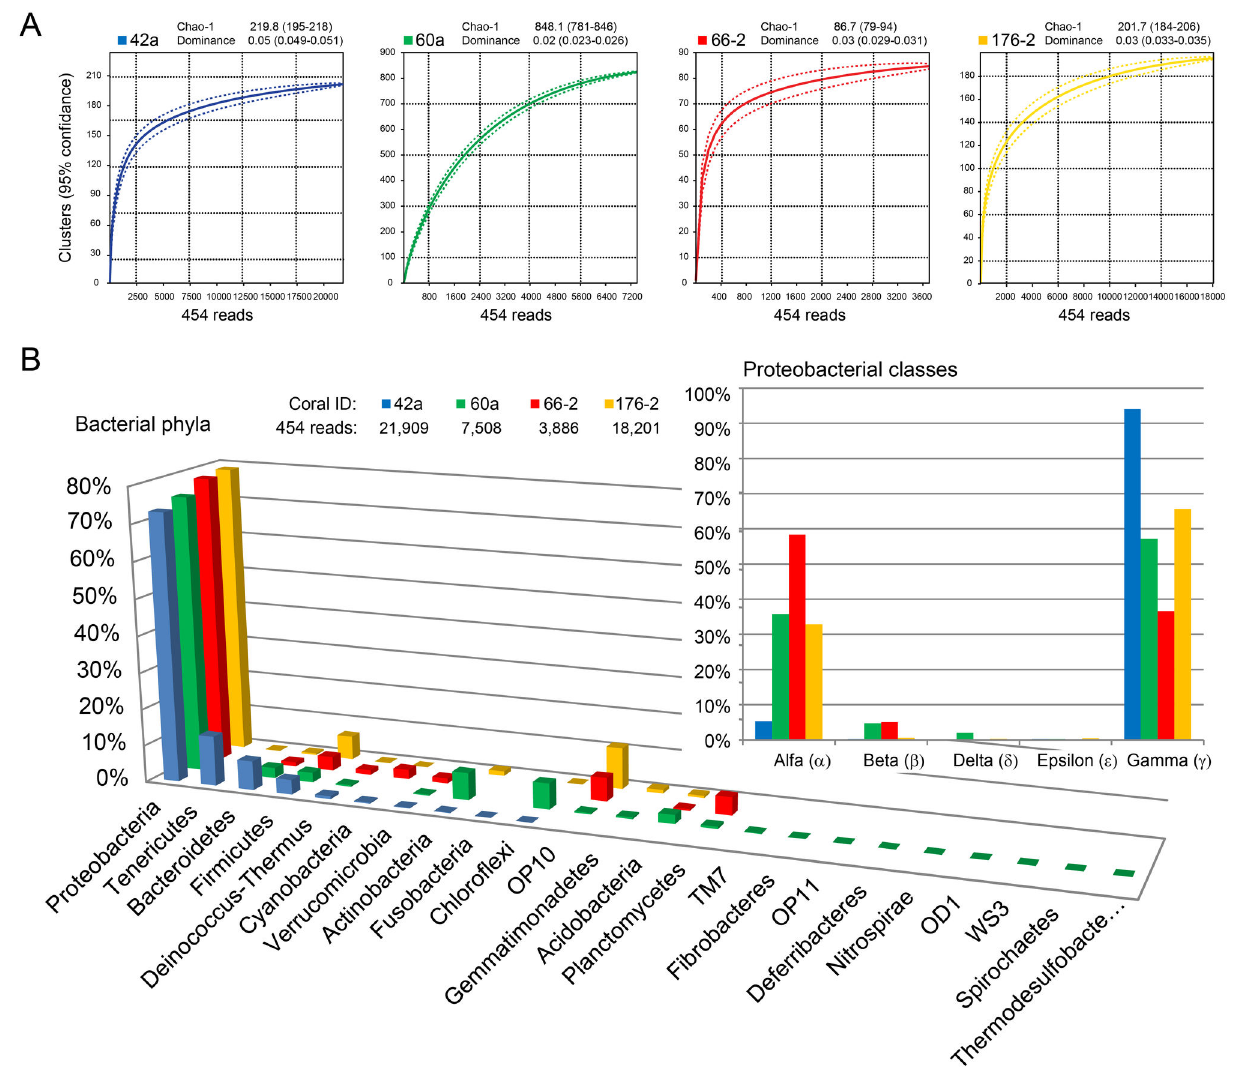
Figure 3. Distribution of bacterial sequences in Great Barrier Reef coral holobionts. (A) Rarefaction curves with 95% confidence interval for sequences obtained using bacterial tag encoded 454 amplicon pyrosequencing assays targeting small- subunit rRNA gene assays (Bac1). Dominance and Chao-1 are indicated above each graph. (B) Abundance of